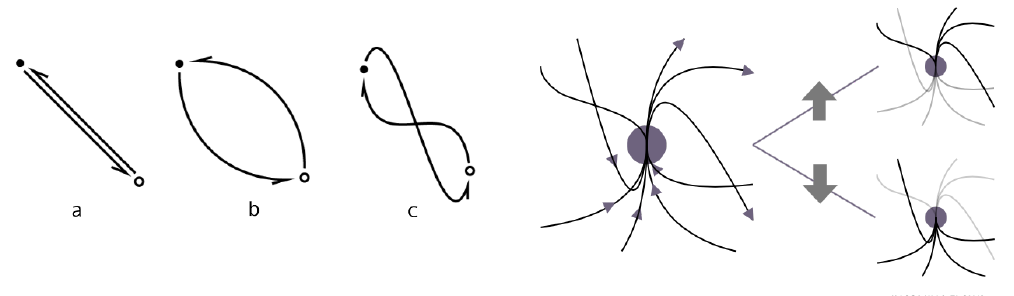
Figure 4. Sinusoidal encoding design space and working schema. Left: Bidirectional flow encoding alternatives: ( a ) straight; ( b ) arched; and, ( c ) sinusoidal, which projects a third dimension into perspective, differentiating in- and outflows in the vertical dimension. Right: schematic view of incoming and outgoing flows at a certain node. Flow direction becomes quickly distinguishable thanks to the sinusoidal flow